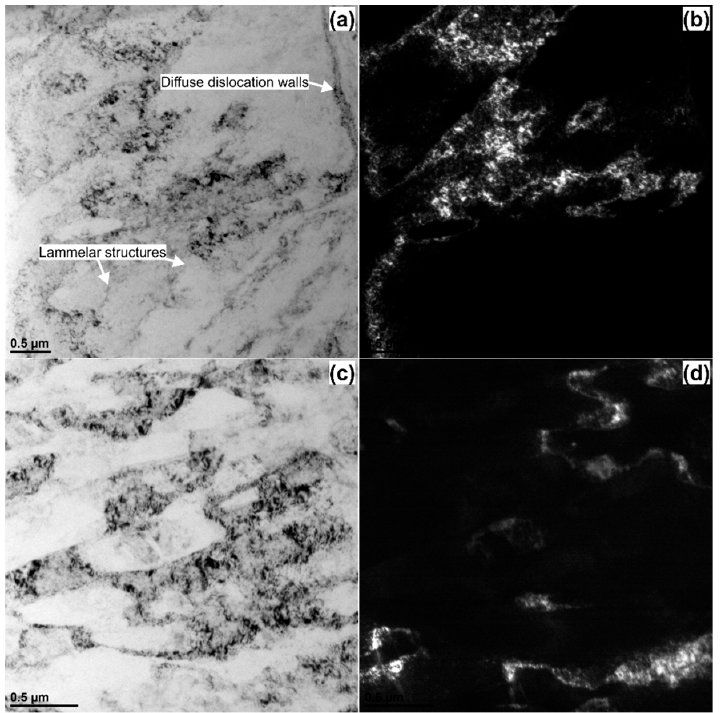
Figure 7. Bright and dark field TEM images of the AlMg3 alloy ( a ) and ( b ) upsetting without USV, ( c ) and ( d ) upsetting with USV.